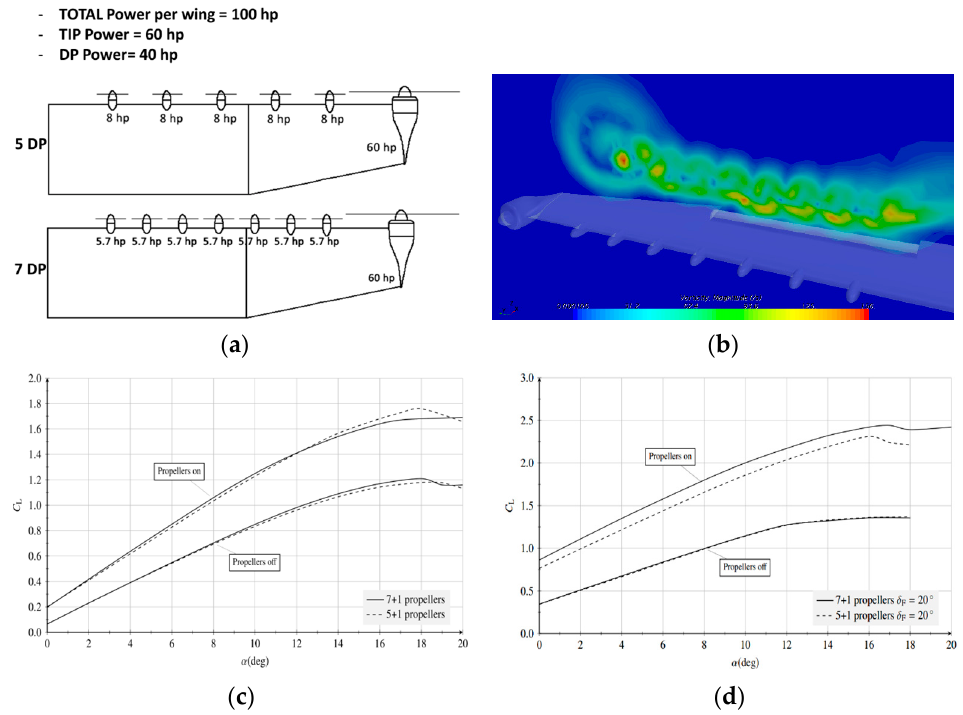
Figure 25b. The pitching moment increment due to high-lift propellers is not negligible, as shown in Figure 25c.